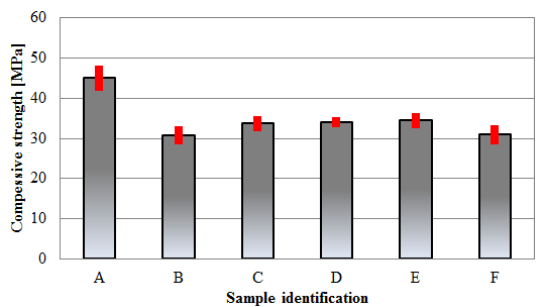
Figure 5. Compressive strength of the